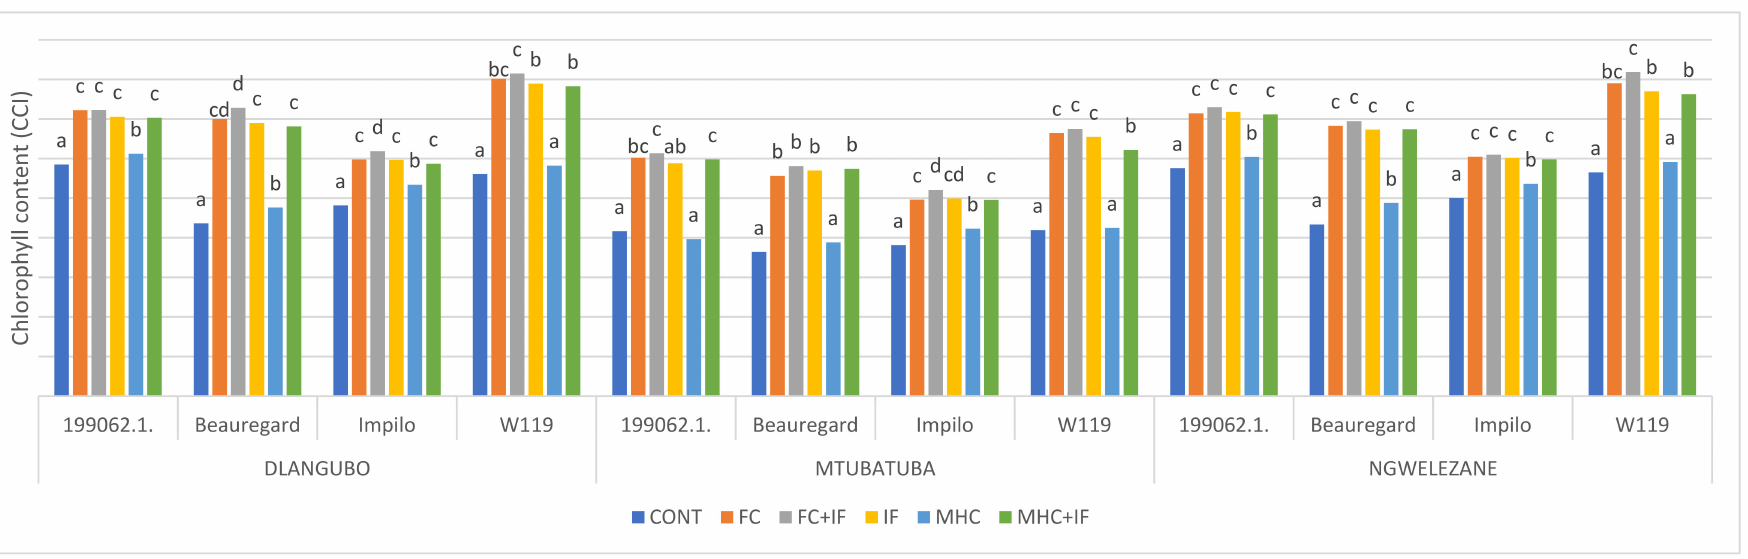
Figure 5. Chlorophyll content in the leave of orange-fleshed sweet potato grown at Dlangubo, Mtubatuba, and Ngwelezane. Each bar represents the average of data collected in season one and season two of 2021. ANOVA was performed across treatments. Means of replicates were separated at LSD 0.05 . Post hoc was done using a Tukey test. The means of the treatments for each cultivar in a site with different letters were significantly different ( p < 0.05, n =